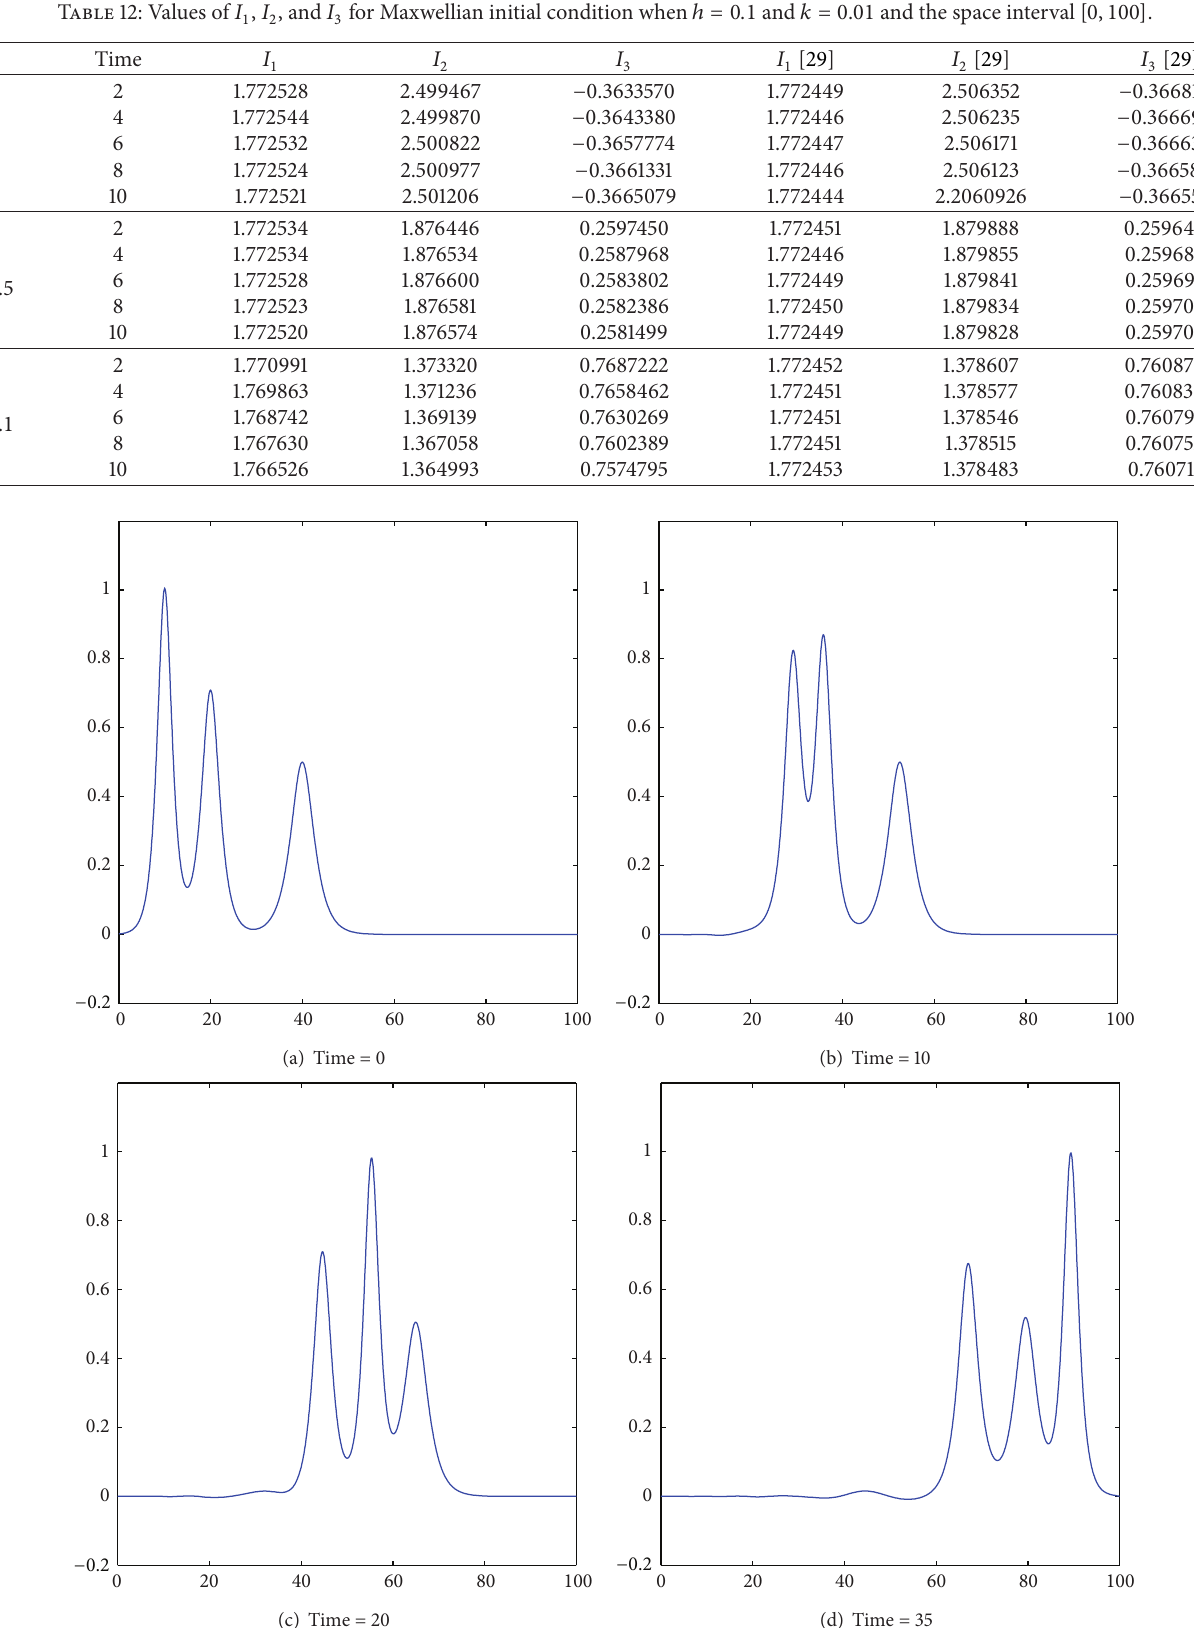
Table 12: Values of 𝐼 1 , 𝐼 2 , and 𝐼 3 for Maxwellian initial condition when ℎ = 0.1 and 𝑘 = 0.01 and the space interval [0, 100] .